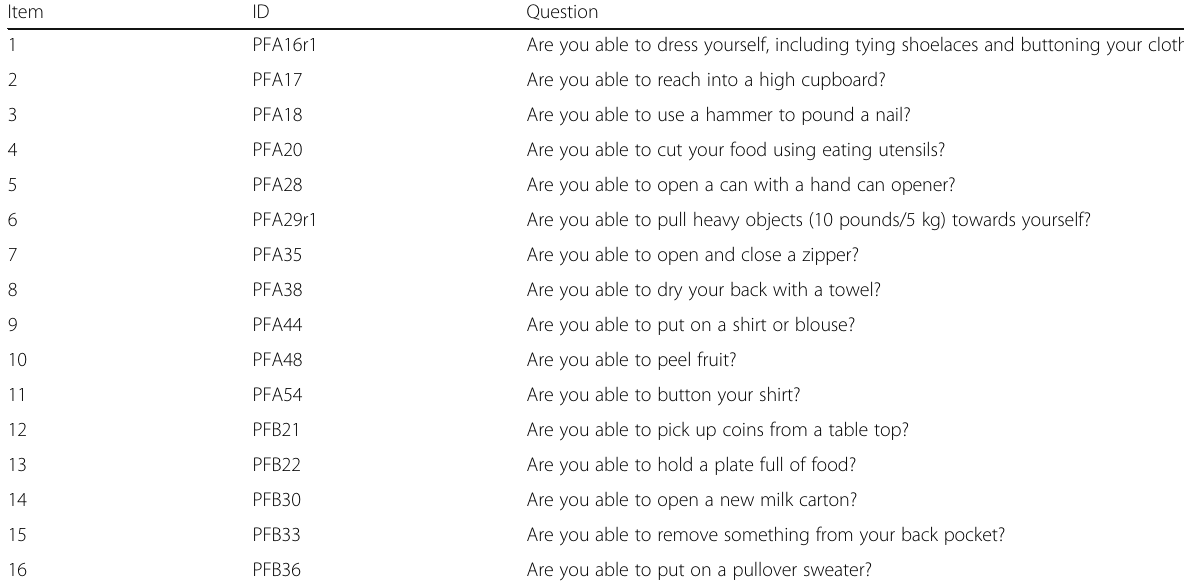
Table 6 PROMIS v1.2 Upper Extremity item